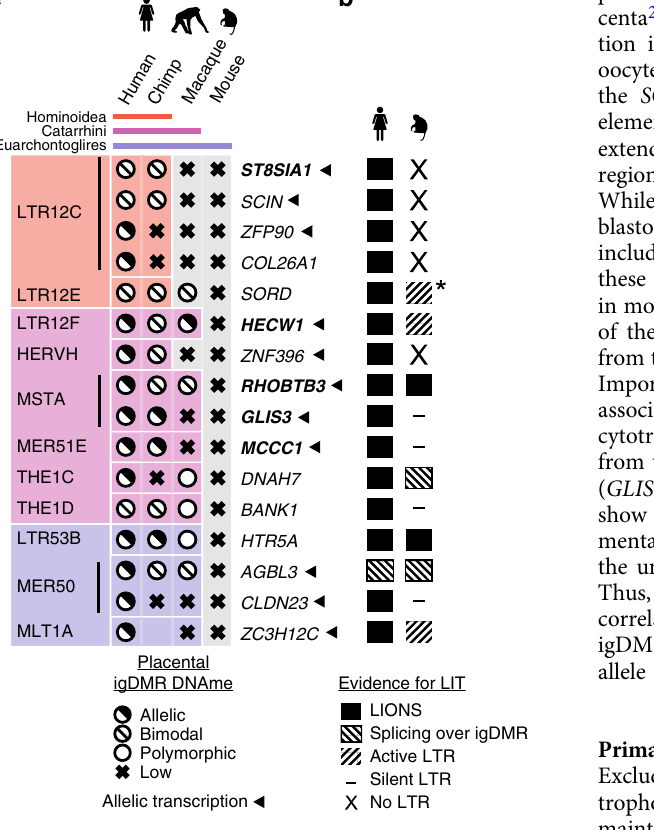
NATURE COMMUNICATIONS| (2019) 10:5674